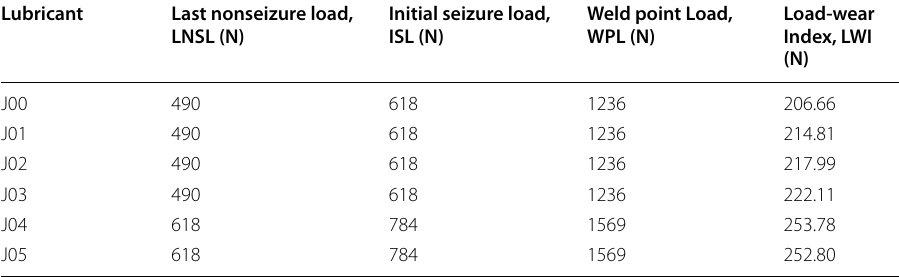
Table 5 Extreme pressure properties of sample lubricants